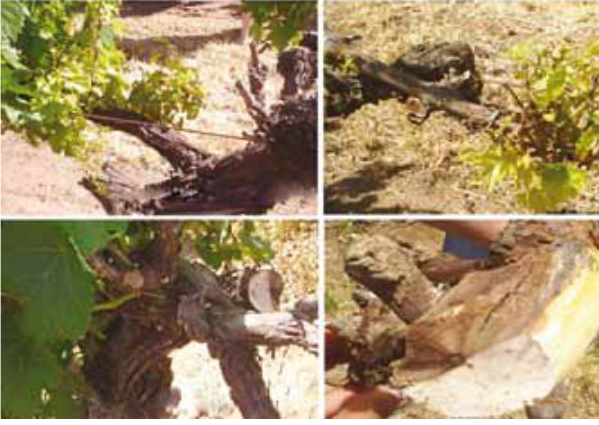
Figure 4: Eutypa dieback Photo: Kovács, 2014, South-Australia, Barossa-Valley Wine Region